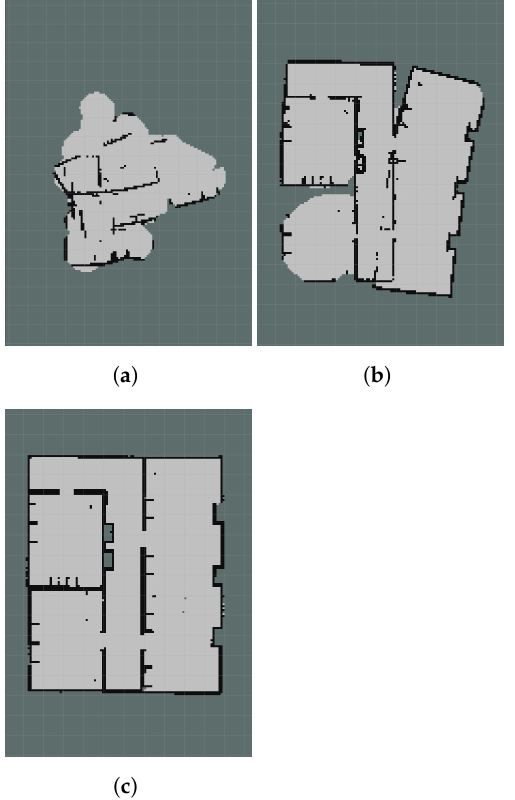
Figure 7. SLAM with artificially restricted LIDAR ranges. ( a ) Maximum range: 1 m. ( b ) Maximum range: 2 m. ( c ) Maximum range: 4